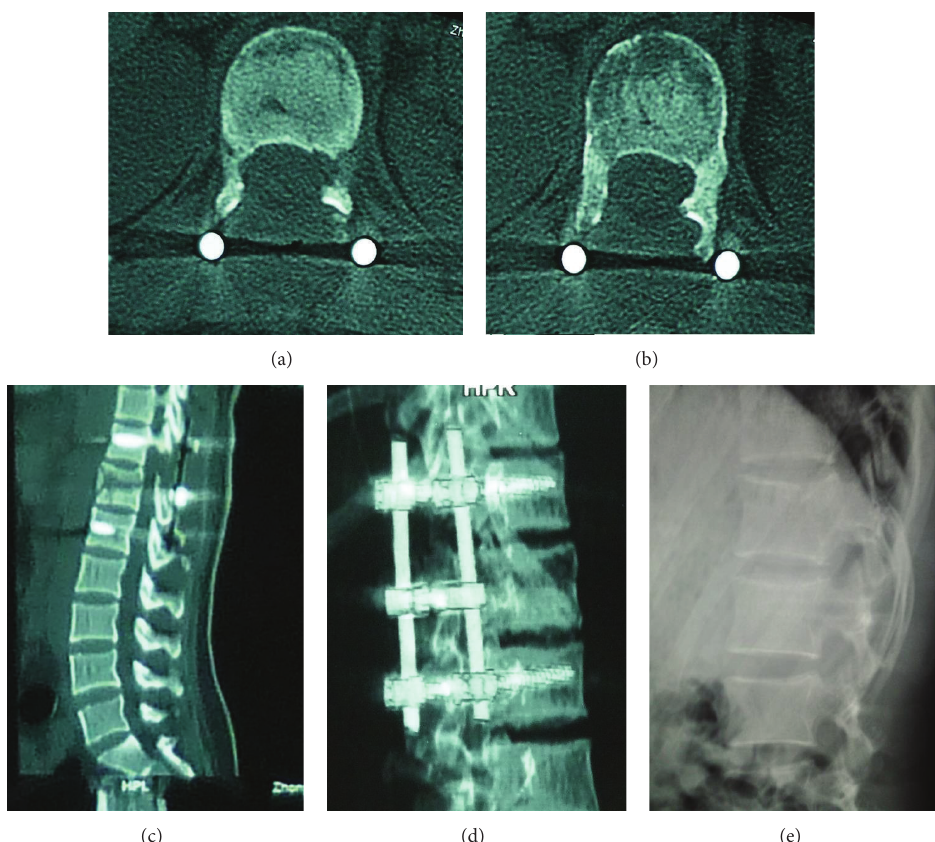
Figure 3: (a)–(d) The postoperative CT scan confirming satisfactory canal clearance and restoration of vertebral body height. (e) After removal of implants for one months, the lateral radiograph showed that the kyphotic angle and vertebral body height were maintained acceptably.